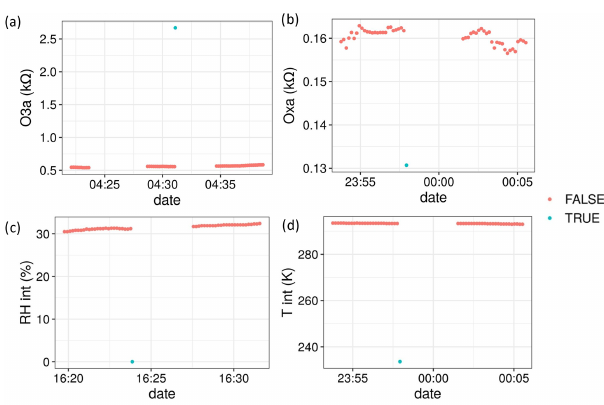
Figure 7. Examples of outliers detected on Zephyr s71 data using a z test with running mean for the SC. A value of “TRUE” means the point was deemed an